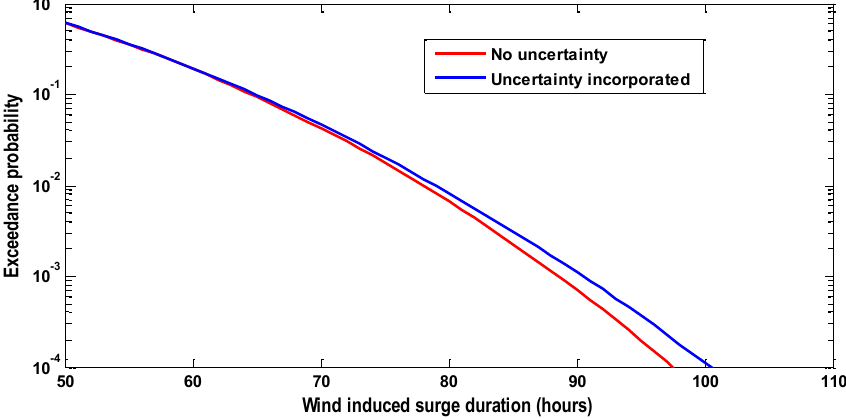
Figure 9. The uncertainty-incorporated marginal distribution of the wind induced storm surge